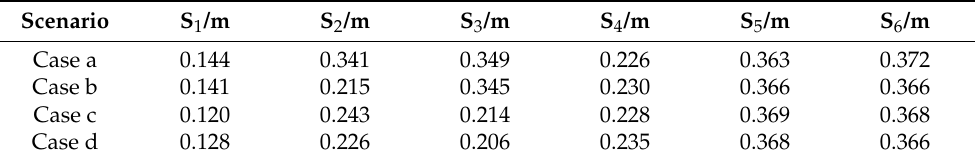
Table 4. Multi-satellite relative navigation results (simulated scenario: Cases a–d, space-circle